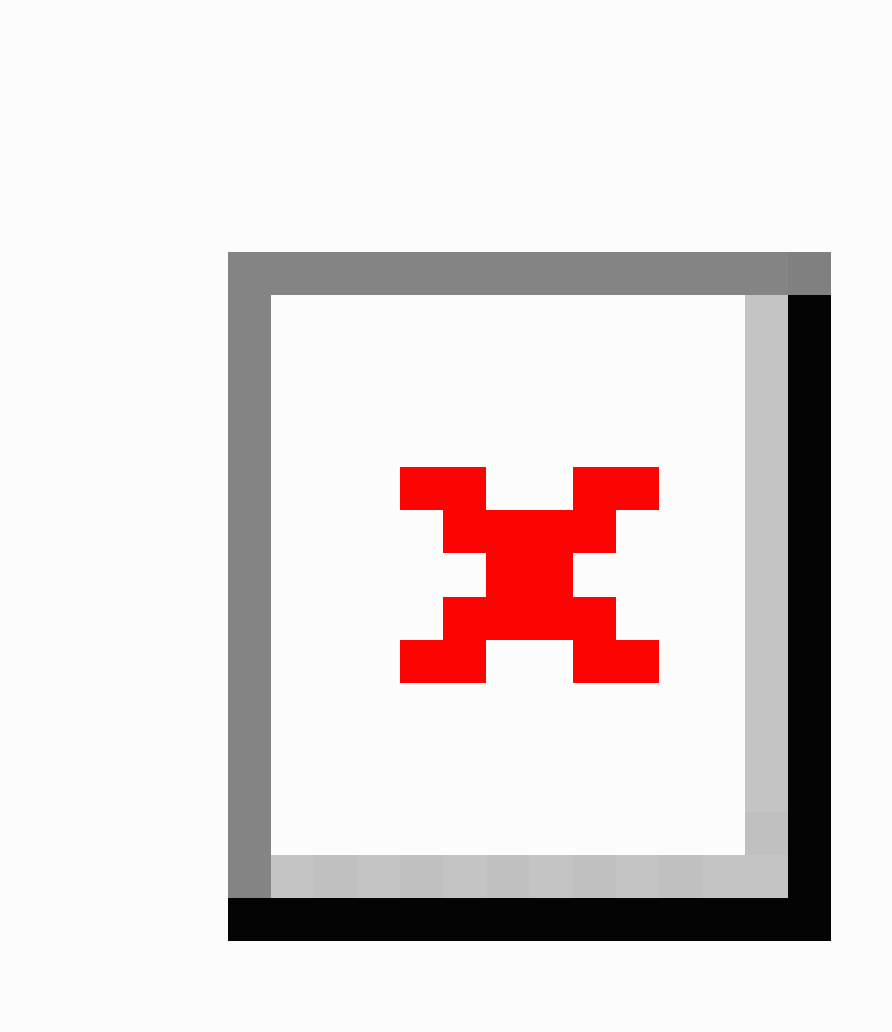
Figure 2. Expected distribution of patients (based partly on CROSS trial data). All numbers are based on an inclusion of 120 patients. CI: confidence interval; CRE: clinical response evaluation; nCRT: neoadjuvant chemoradiotherapy; N: number of patients; TRG: tumor regression grade, as measured by the modified TRG system of Chirieac. Of the 45 patients who will undergo a postponed resection following CRE-II, 15 patients are expected to have a pathologically incomplete response (at least